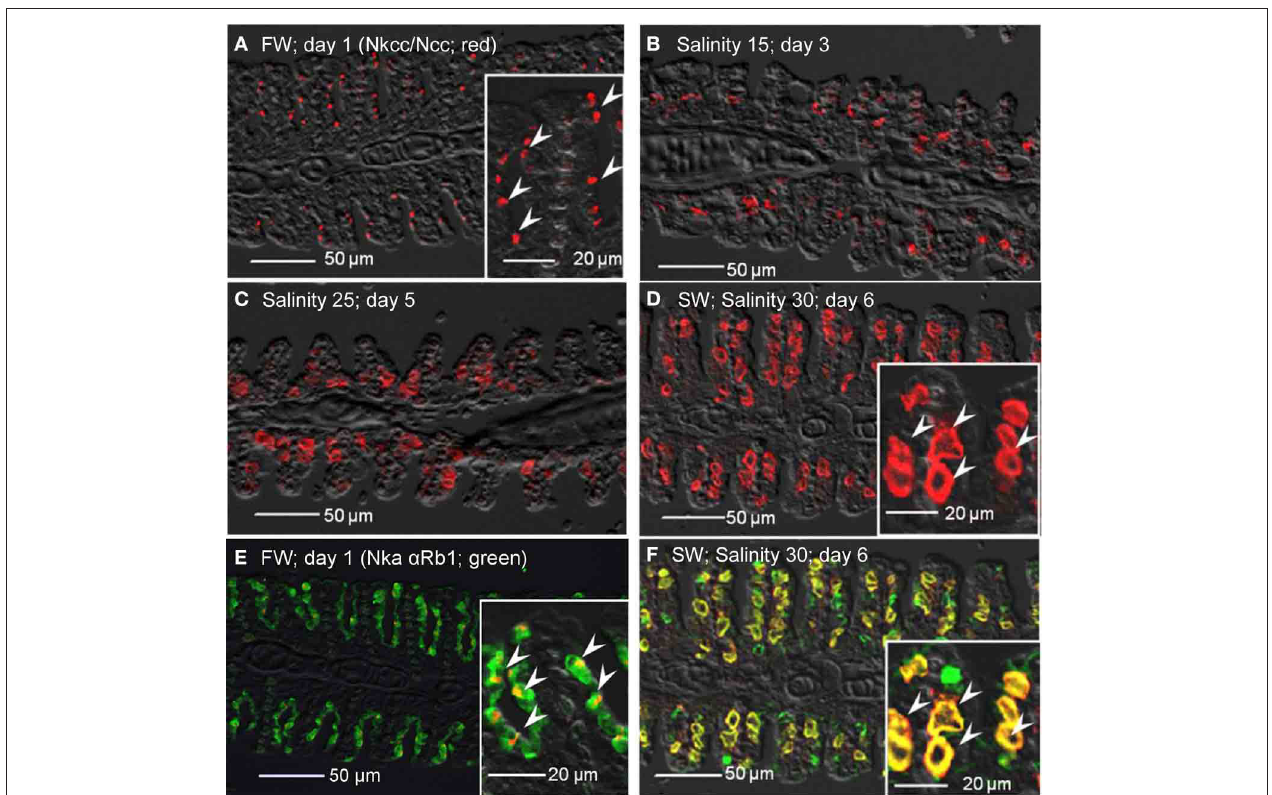
FIGURE 13 | Immunofluorescent localization of Na + :K + :2Cl − cotransporter (Nkcc; red)/Na + :Cl − cotransporter (NCC; red) in the gills of Anabas testudineus kept in (A) freshwater on day 1 (FW; control), or after 24h of exposure to (B) salinity 15 on day 3, (C) salinity 25 on day 5, or (D) salinity 30 (seawater) on day 6 during a progressive acclimation from freshwater to seawater. Double immunofluorescencestaining with anti-NKCC/NCC and anti-NKA α Rb1 (green) antibodies was performed on gills of fish kept in (E) freshwater on day 1, or (F) salinity 30 (seawater) on day 6. Co-localization of staining from the red and green channels resulted in a